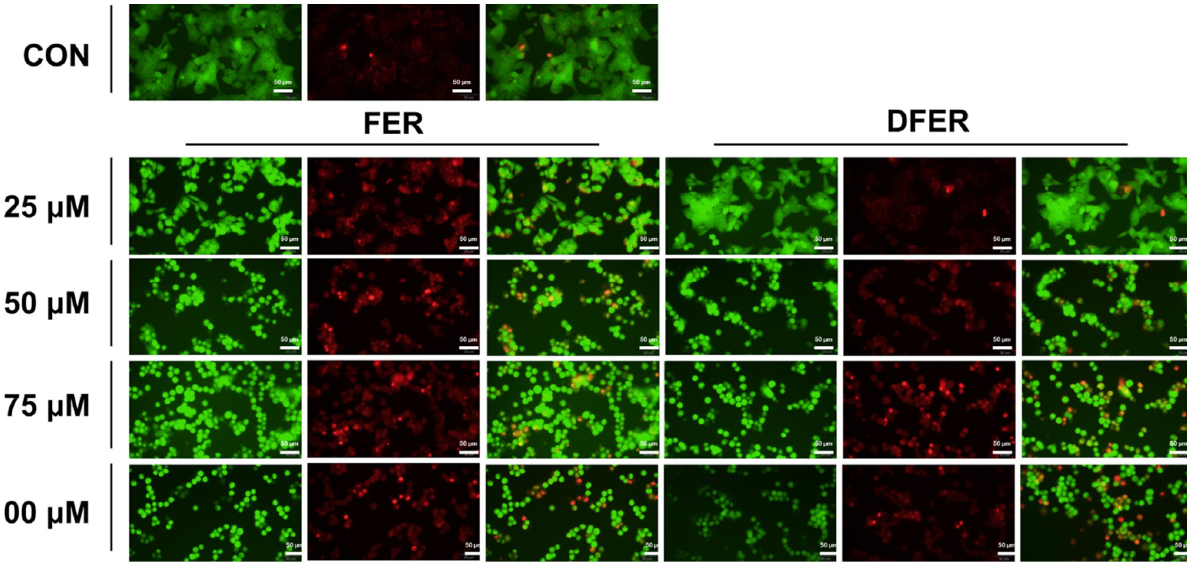
Figure 6. Changes in cell morphology and DNA condensation occur in FER- or DFER-treated HCT116 at different concentrations. HCT116 cells were treated with FER or DFER at various concentrations and were stained with EtBr/Acridine Orange to observe the changes in cell morphology and DNA condensation or fragmentation. Condensed or DNA fragmentation or necrotic cells were stained with observable sharp light green or orange, under excitation/emission wavelengths of 488/530 nm or 530/625 nm, respectively.